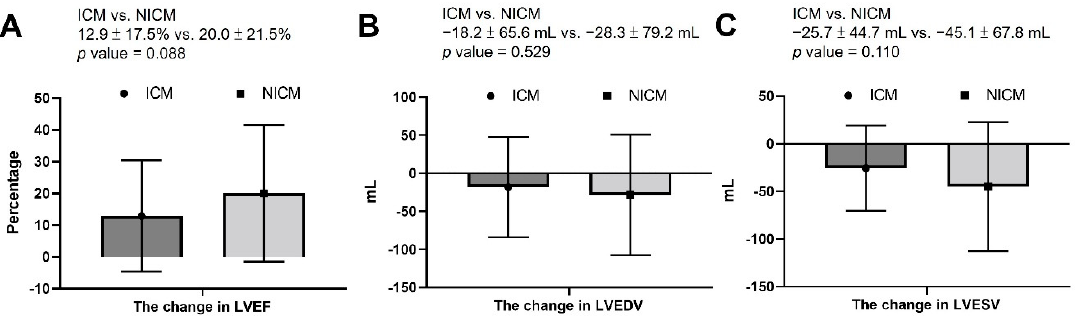
Figure 1. The change in LVEF, LVEDV, and LVESV: ( A ) the change in LVEF was higher in the NICM group, albeit nonsignificant; ( B ) the change in LVEDV did not differ between the ICM and NICM groups; ( C ) the change in LVESV did not differ between the ICM and NICM groups. LVEF: left ventricular ejection fraction; LVEDV: left ventricular end-diastolic volume; LVESV: left ventricular end-systolic volume; ICM: ischemic cardiomyopathy; NICM: non-ischemic cardiomyopathy. Table 2. Two-day later hemodynamic condition and follow-up echocardiographic parameters.